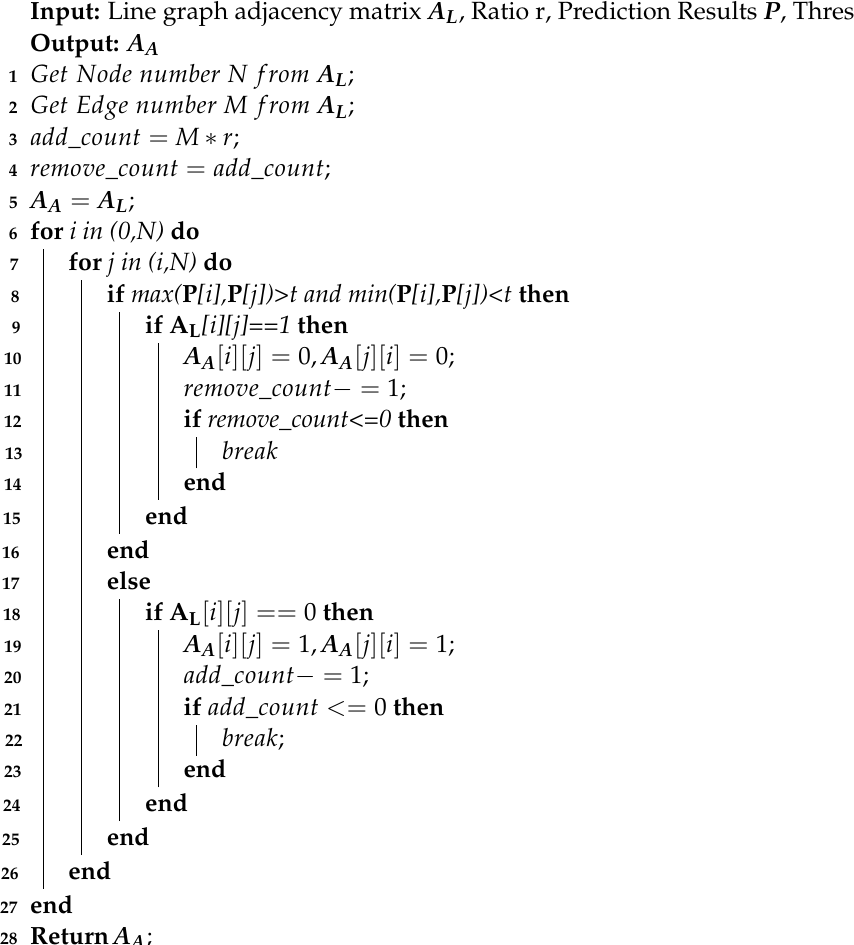
Algorithm 1: Adaptive Line Graph Augmentation